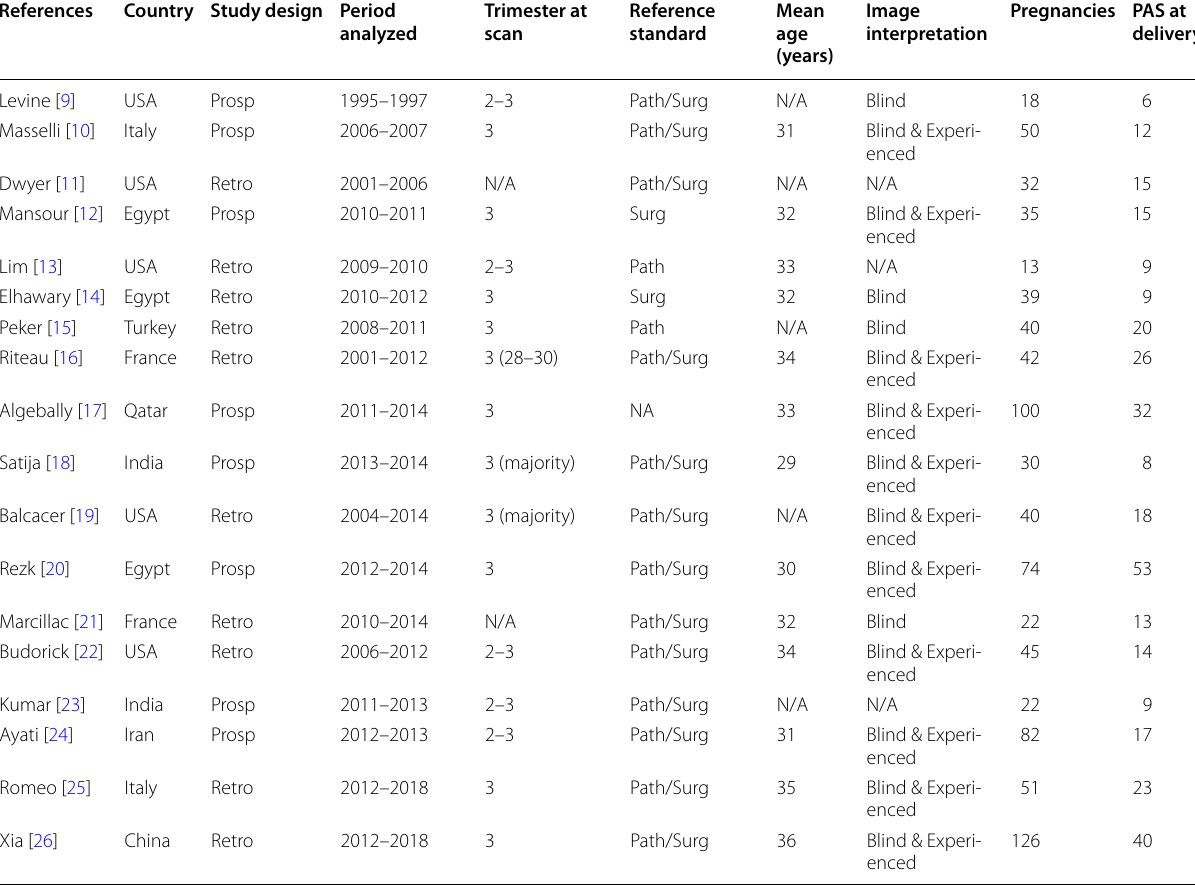
Table 1 General characteristics of studies included in the systematic review (18 studies)